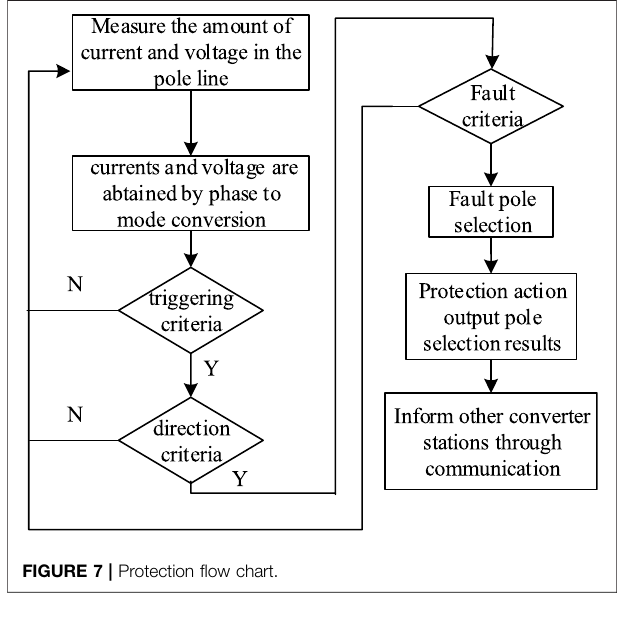
FIGURE 7 | Protection fl ow